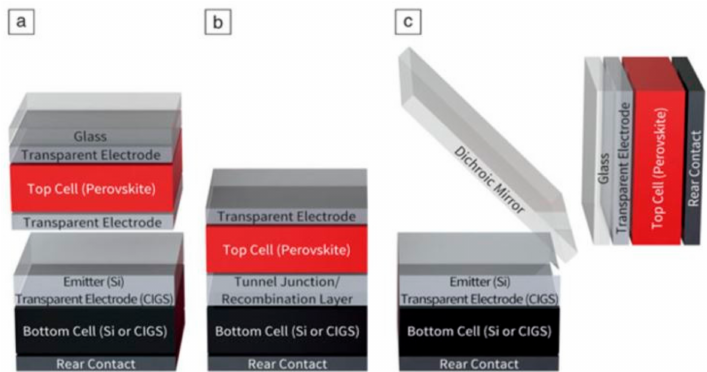
Figure 4. Tandem architecture in terms of internal stacking: ( a ) mechanically Stacked; ( b ) monolithically integrated; and ( c ) spectrally split. Taken from Bailie et al.